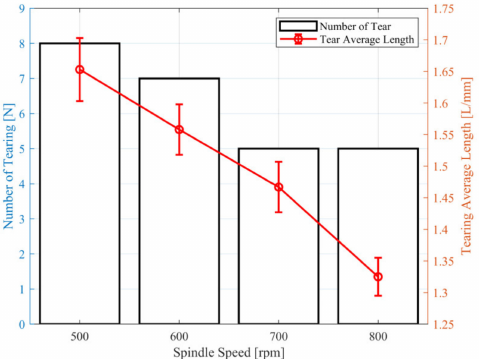
Figure 17. The effect of ultrasonic spindle speed on surface